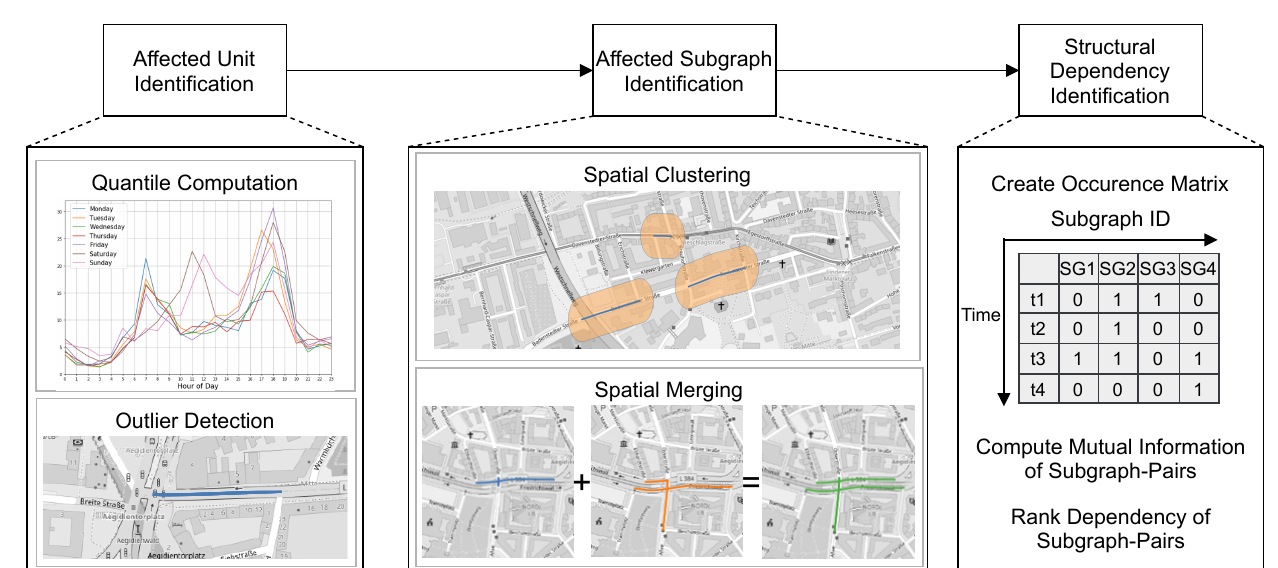
Figure 2. ST-D ISCOVERY pipeline overview. Map images: c (cid:13) OpenStreetMap contributors,